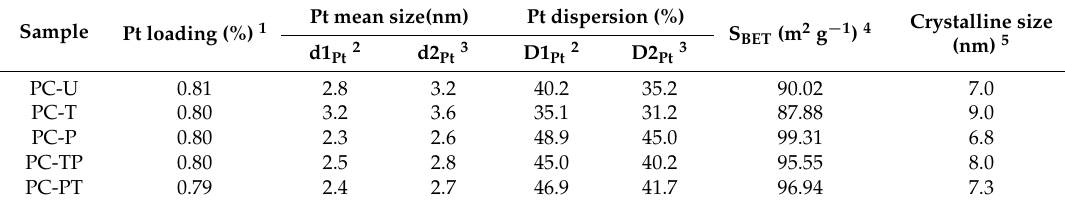
Table 2. Structural parameters of various